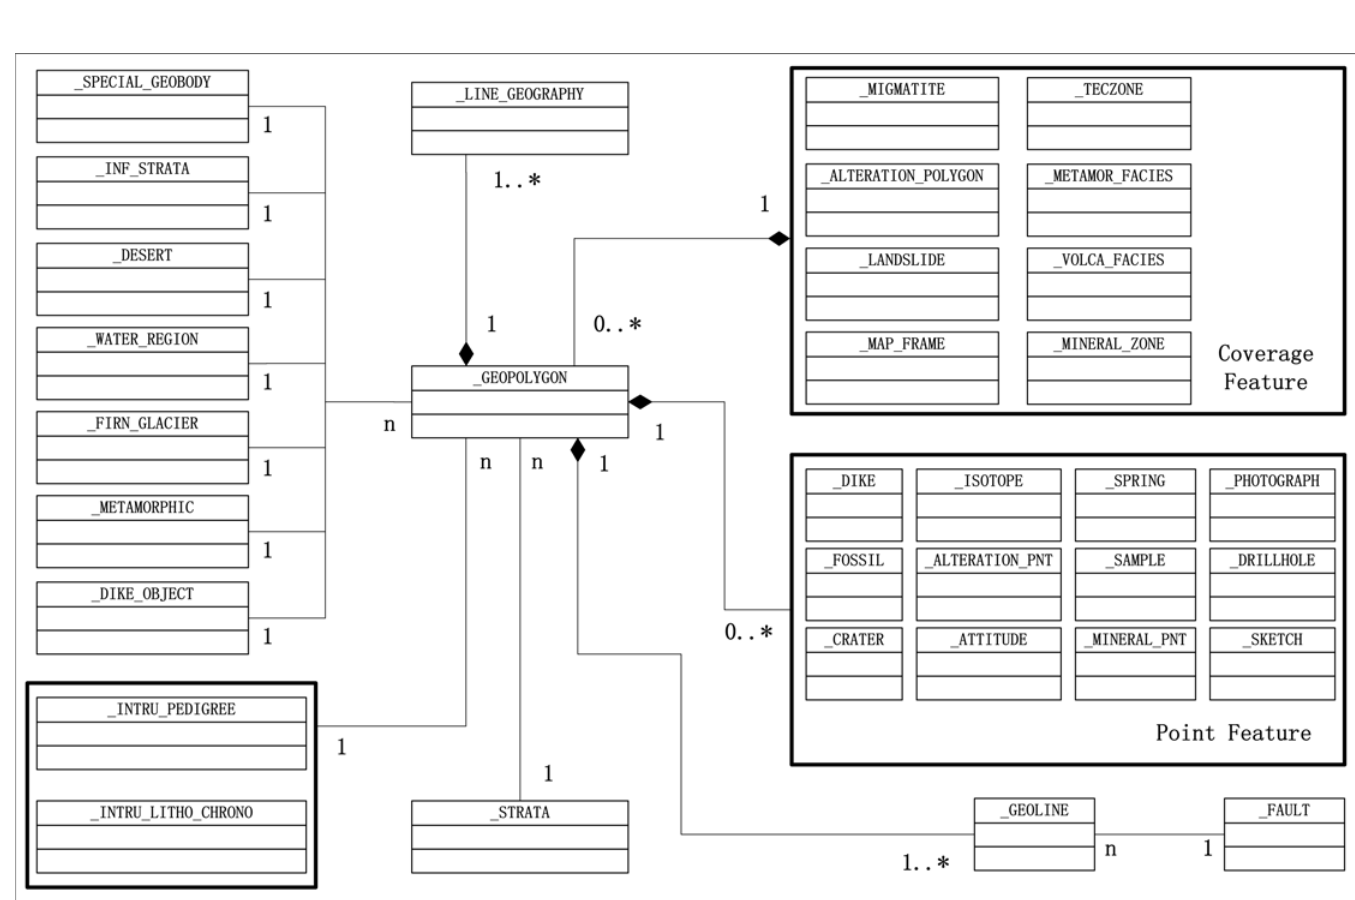
Fig 2. Data model framework of the geologic